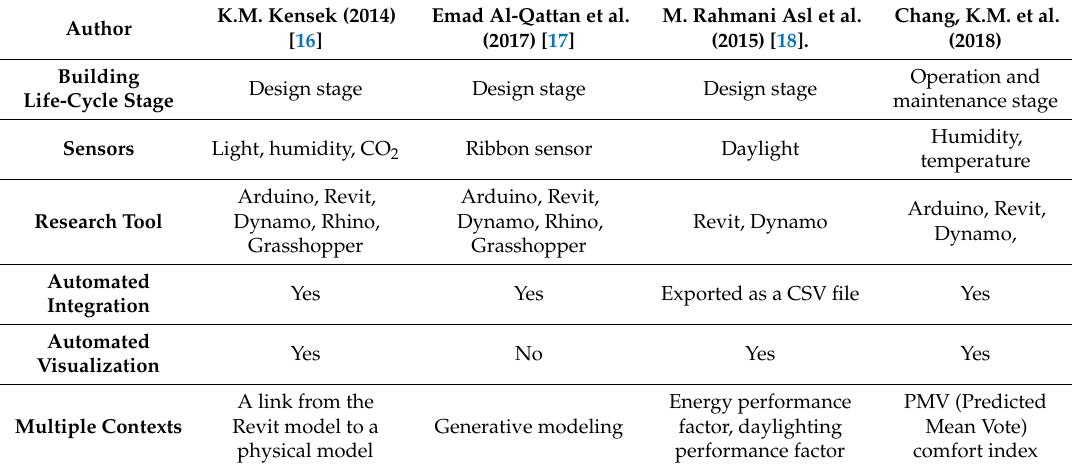
Table 1. Comparison with differences in past research